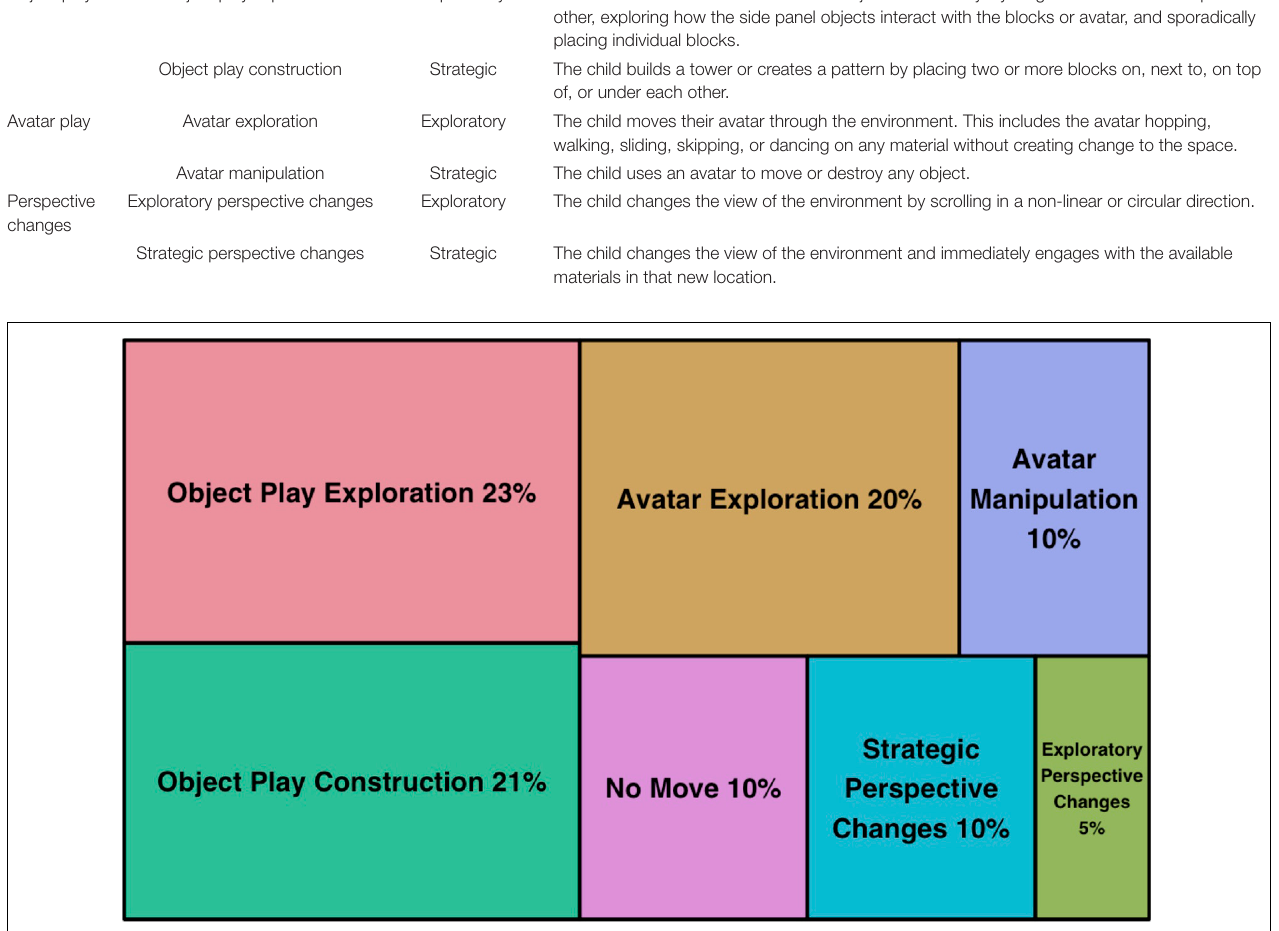
FIGURE 4 | Treemap illustrating the percentage of Toca Blocks play time children on average spent engaging in each play behavior.